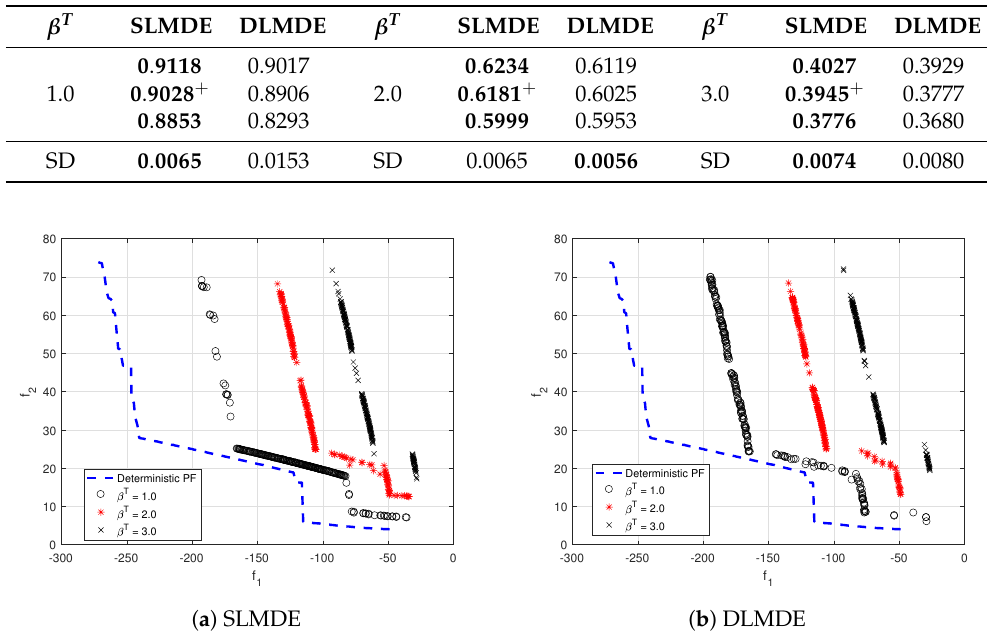
Figure 4. The PO solutions obtained via both methods for example 2, for different β T values.